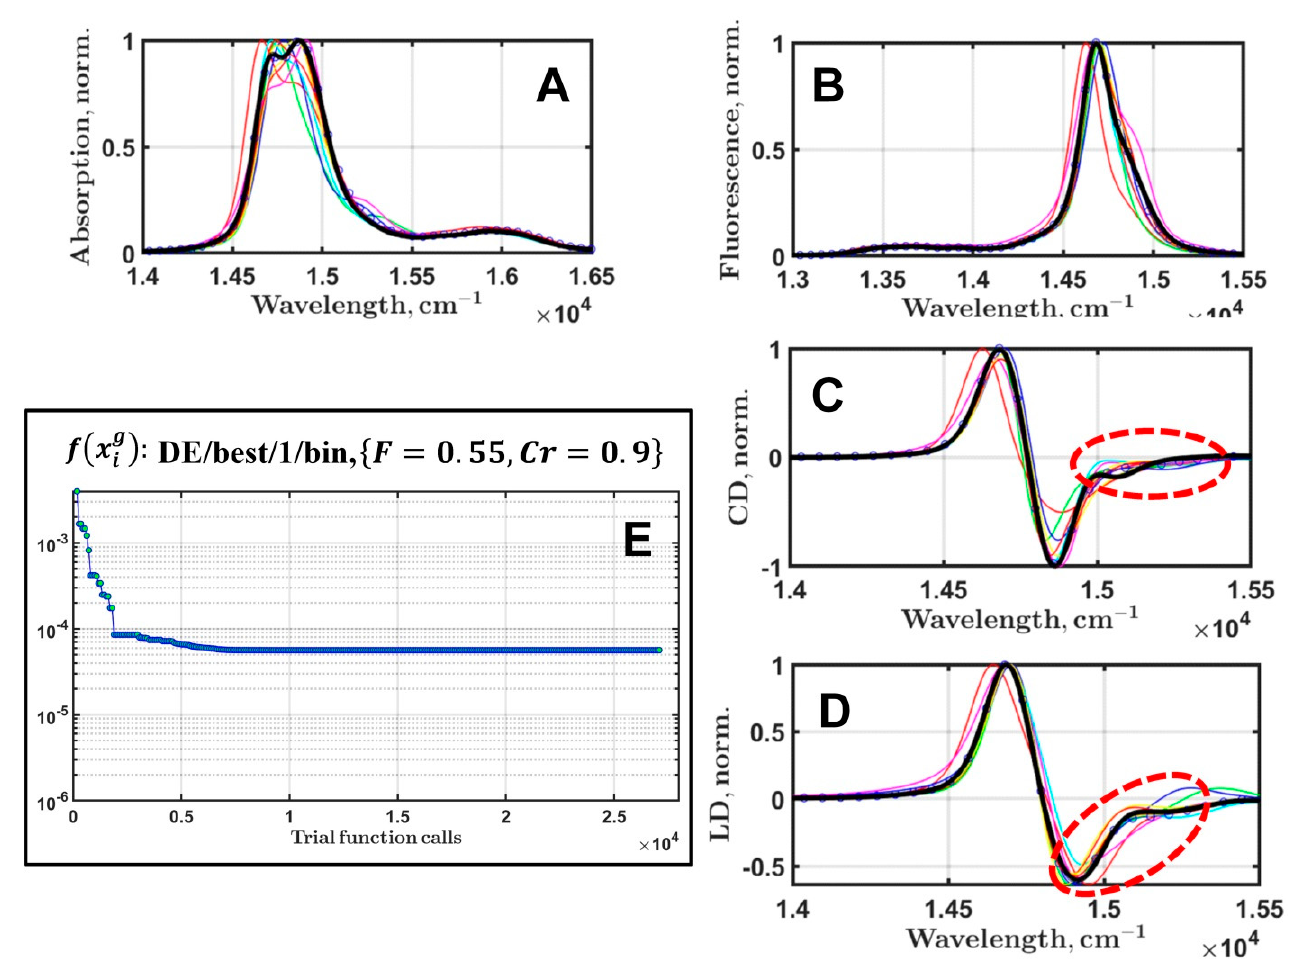
Figure 4. Results of the PSIIRC linear optical response fitting. The case when DE is stuck in a local minimum. DE/best/1/bin strategy. The best simulated spectra (black lines with circular markers) of absorption ( A ), steady-state fluorescence ( B ), circular ( C ), and linear ( D ) dichroism are shown. Color lines are the spectra found by DE after first 7 generations. Black thick lines are the target spectra. Red ovals indicate those parts of the spectra where there are significant discrepancies between the target spectra and those found by DE. The objective function f dependence on the number of the trial function (linear response simulation) calls ( E ).